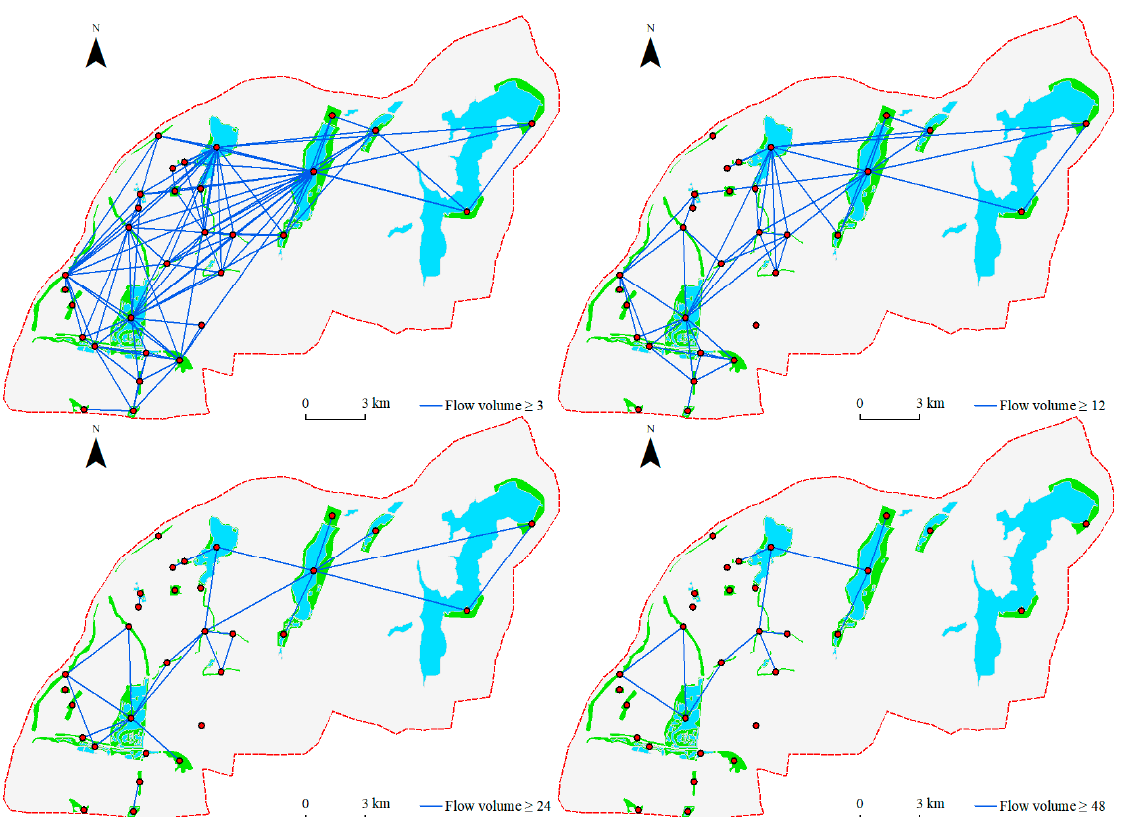
Figure 5. The flow network under different flow